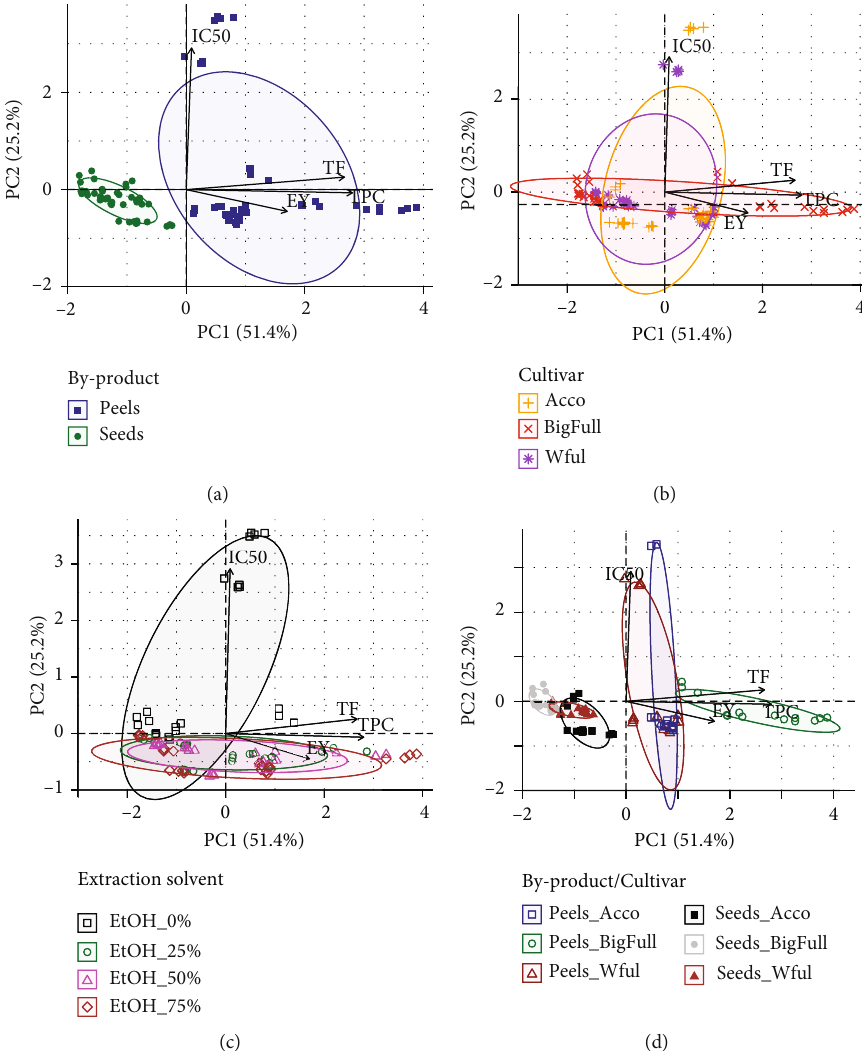
Figure 3: 2D-PCA plots for the pomegranate extract classi fi cation based on the experimental extraction yields (EY), total phenolic compounds (TPC), total fl avonoids (TF), and antioxidant activity (AA assessed in terms of IC of by-product (peels or seeds), (b) the cultivar (Acco, Big Full, and Wonderful), (c) the type of extraction solvent (EtOH: 0%, 25%, 50%, 75%), and (d) the by-product and the cultivar